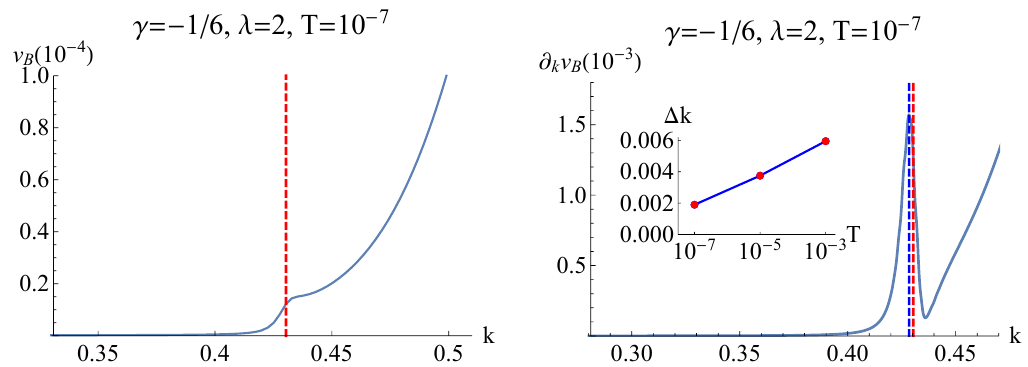
Figure 4 . The butterfly velocity v B and its derivative with respect to k as the function of k for γ = − 1 / 6 at T = 10 − 7 . The inset in the right plot is for the temperature dependence of ∆ k , which is the difference between the positions of QCPs and the local maxima of ∂ lines are the positions of QCPs and the blue dashed lines are the local maxima of ∂ fix λ = 2 .